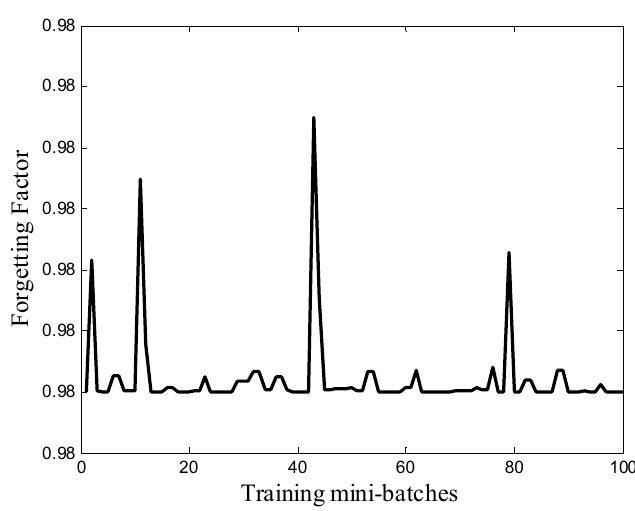
Figure 6. Dynamic forgetting function behavior during training.